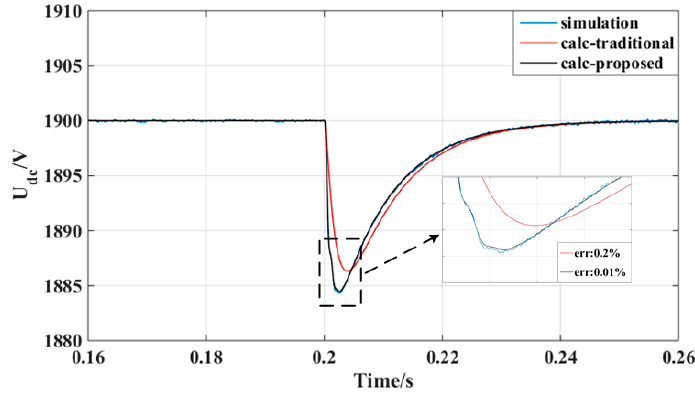
Figure 10. The waveform of the grid current peak value (power inversion).